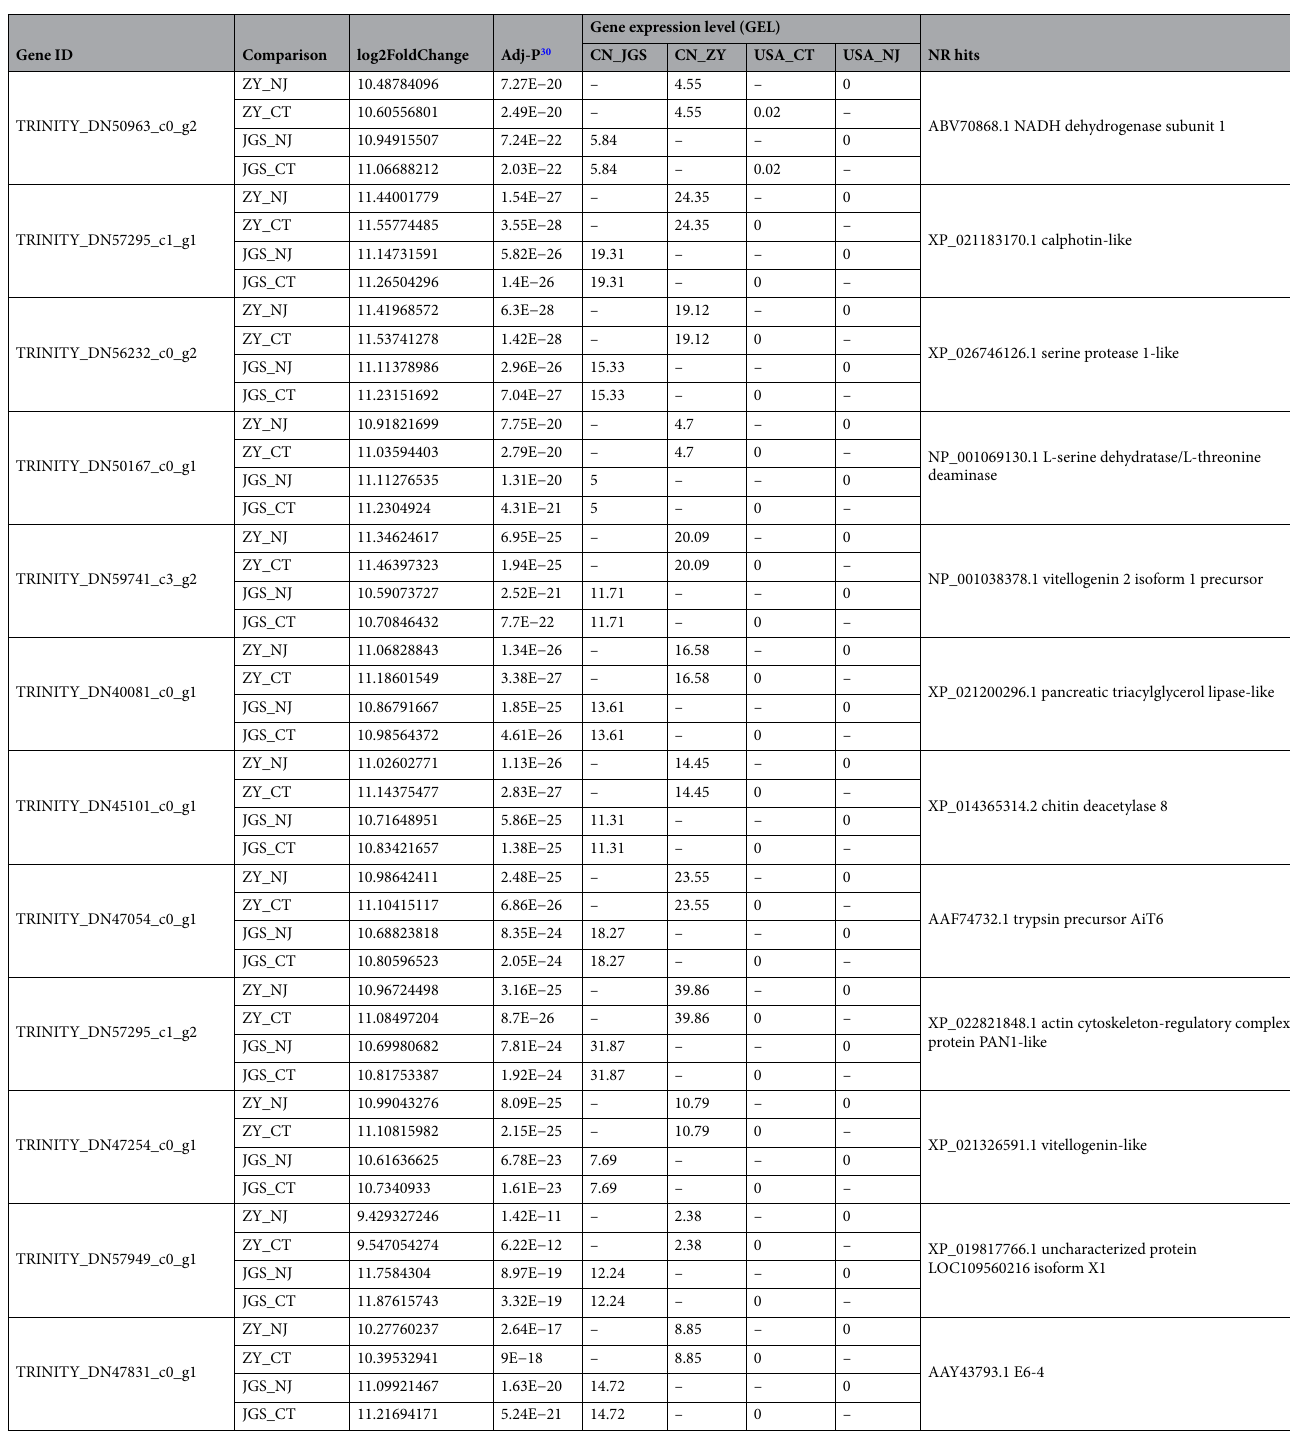
Table 4. Genes that were consistently differentially expressed in all comparisons in four ASM and ESM transcriptomes. DEGs are sorted in descending order with respect to log2-fold change, with down-regulated DEGs listed first, followed by up-regulated